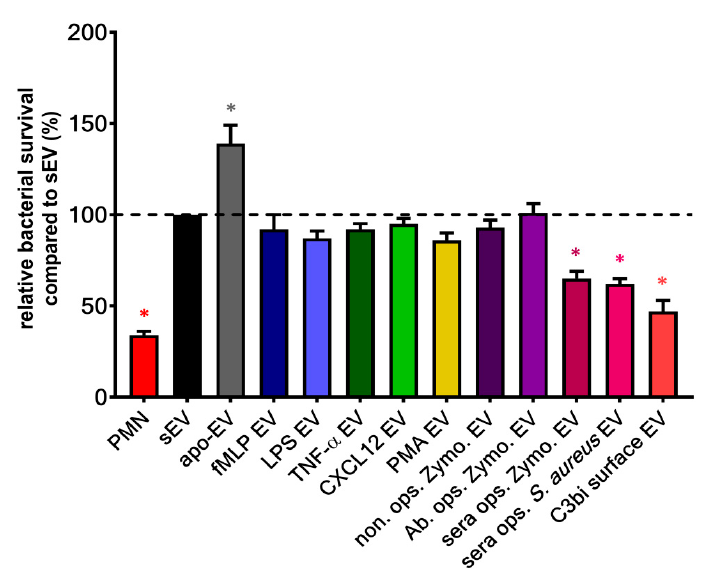
Figure 3. Bacterial survival in the presence of different types of neutrophil EVs. EVs were tested immediately after isolation. The amount of the applied EVs was normalized to protein content. The optical-density-based quantification of the bacterial survival of S. aureus was carried out as detailed in [149]. Error bars represent mean + S.E.M. Data were compared to sEV by using one-way ANOVA coupled with Dunett’s post hoc test; n = 3 (PMA EV), 4 (fMLP EV, TNF- α EV, LPS EV, CXCL12 EV, C3bi surface EV, apo EV), 11 (non ops. Zymo. EV, Ab. ops. Zymo. EV, sera ops. Zymo. EV), 25 (PMN,